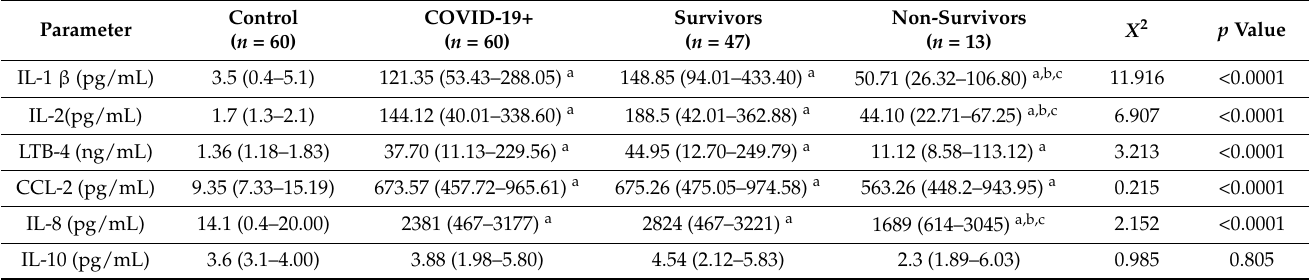
Table 3. Comparison of cytokine and chemokines levels between subjects with and without COVID.